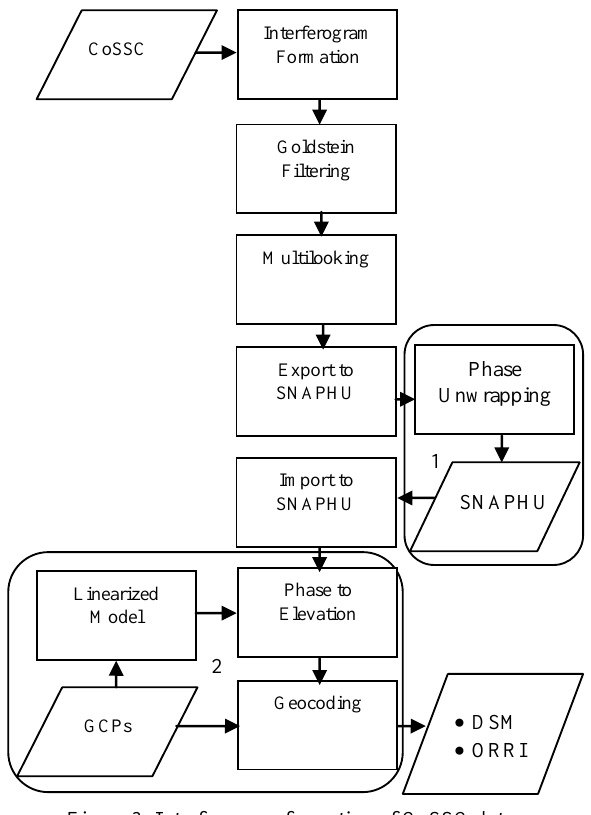
Figure 3. Interferogram formation of CoSSC